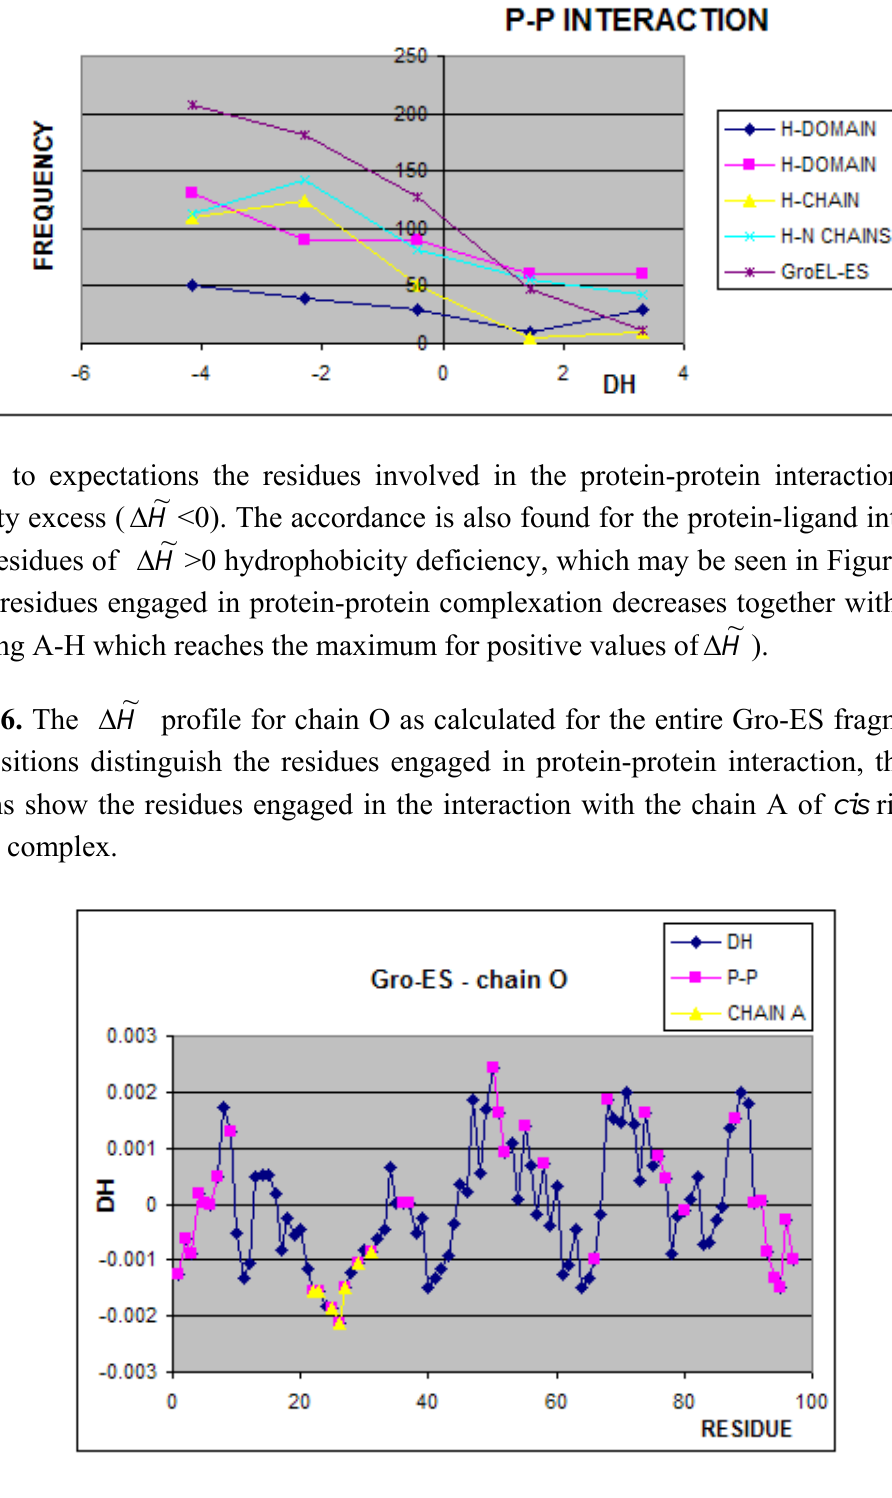
Figure 5. Frequency of the values of H protein (P-P) interaction. The negative H